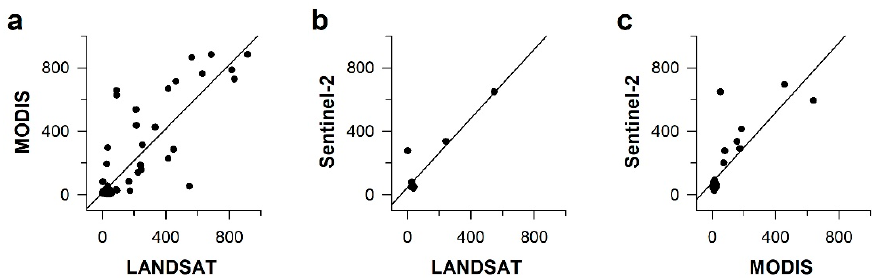
Figure 8. Correlation of inundation data between different sensors. Monthly inundated area captured from one sensor is plotted on the x -axis and the other is plotted along the y -axis. ( a ) Left picture: Landsat and MODIS Sensors; ( b ) Middle picture: Landsat and Sentinel-2 Sensors and ( c ) Right picture: MODIS and Sentinel-2 Sensors.